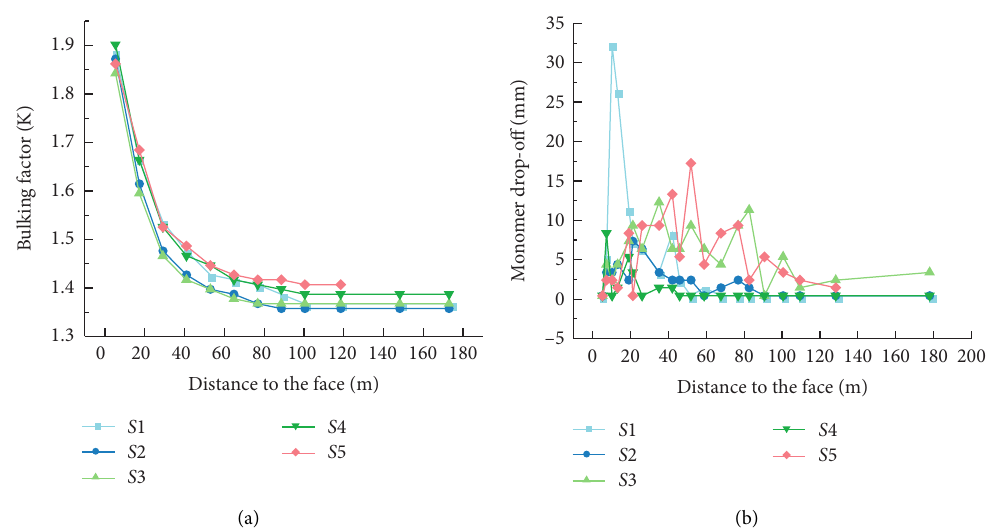
Figure 20: Layout of grouting bolts.